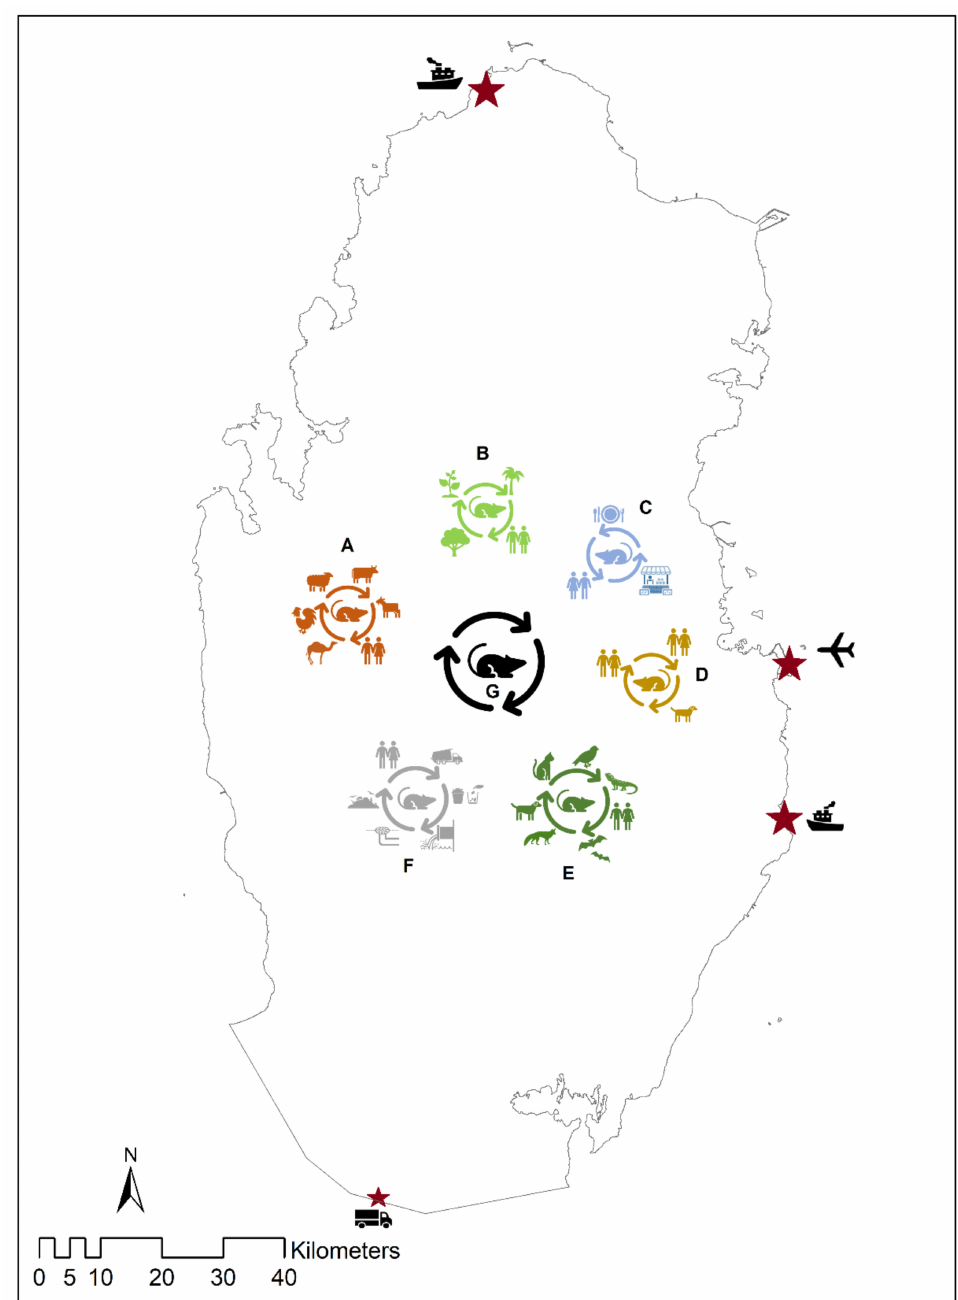
Figure 2. Possible transmission pathways of the rodent-related zoonotic pathogens at the human–animal–environmental interface in Qatar. The stars indicate the plausible routes of entry of rodent-related pathogens in Qatar via carrier immigrants and the importing of contaminated food and agricultural products. “A” indicates that rodents can be a source of transmission of pathogens among livestock animals and humans inside Qatar. Similarly, the figure illustrates how rodents can facilitate zoonotic pathogens transmission among agricultural products and humans “B”, residential areas between humans and pet animal “C”, in the environment between stray cats and dogs, wildlife, and humans “D”, fresh food in households, restaurants, markets, and humans “E”, and through the sewage system “F”. Rodents can interlink zoonotic pathogens “G” between A, B, C, D, E, and